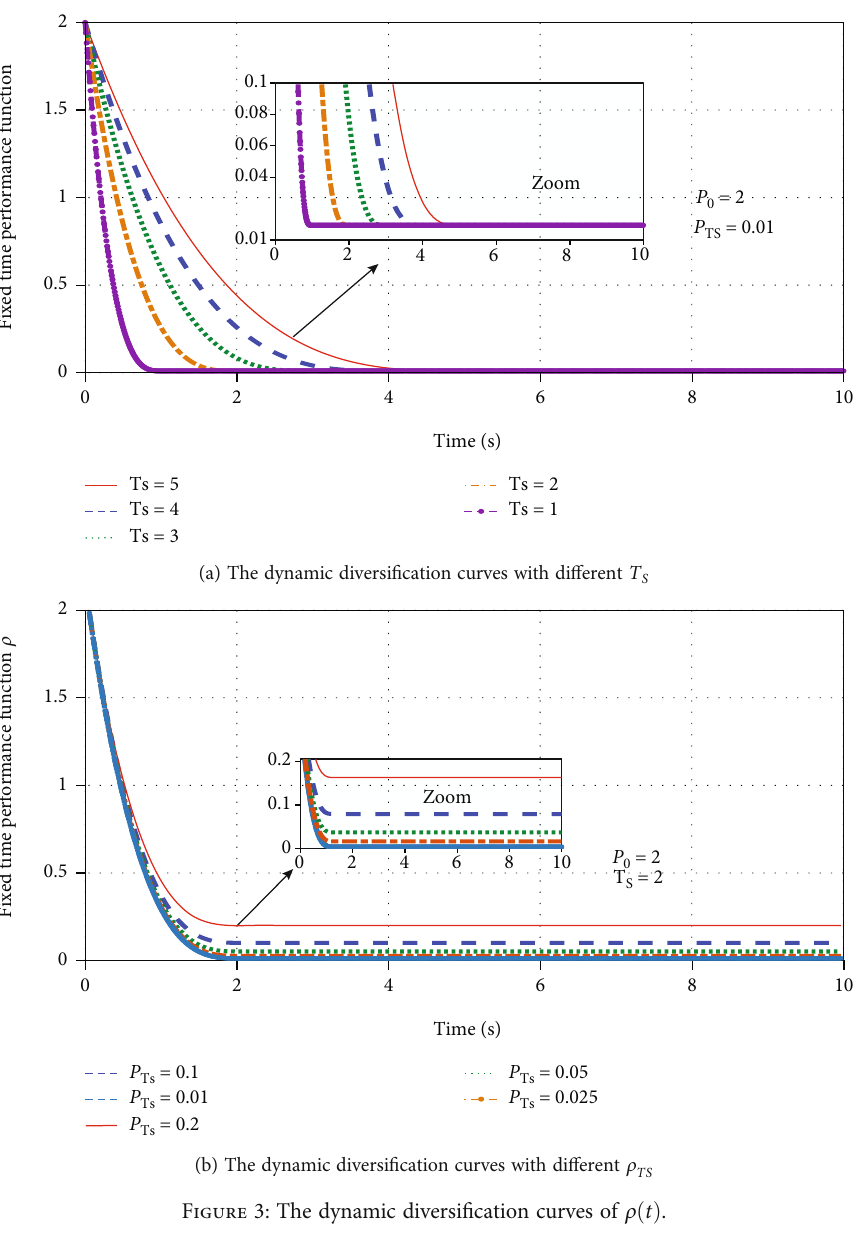
(b) The dynamic diversi fi cation curves with di ff erent ρ Figure 3: The dynamic diversi fi cation curves of ρ ð t Þ